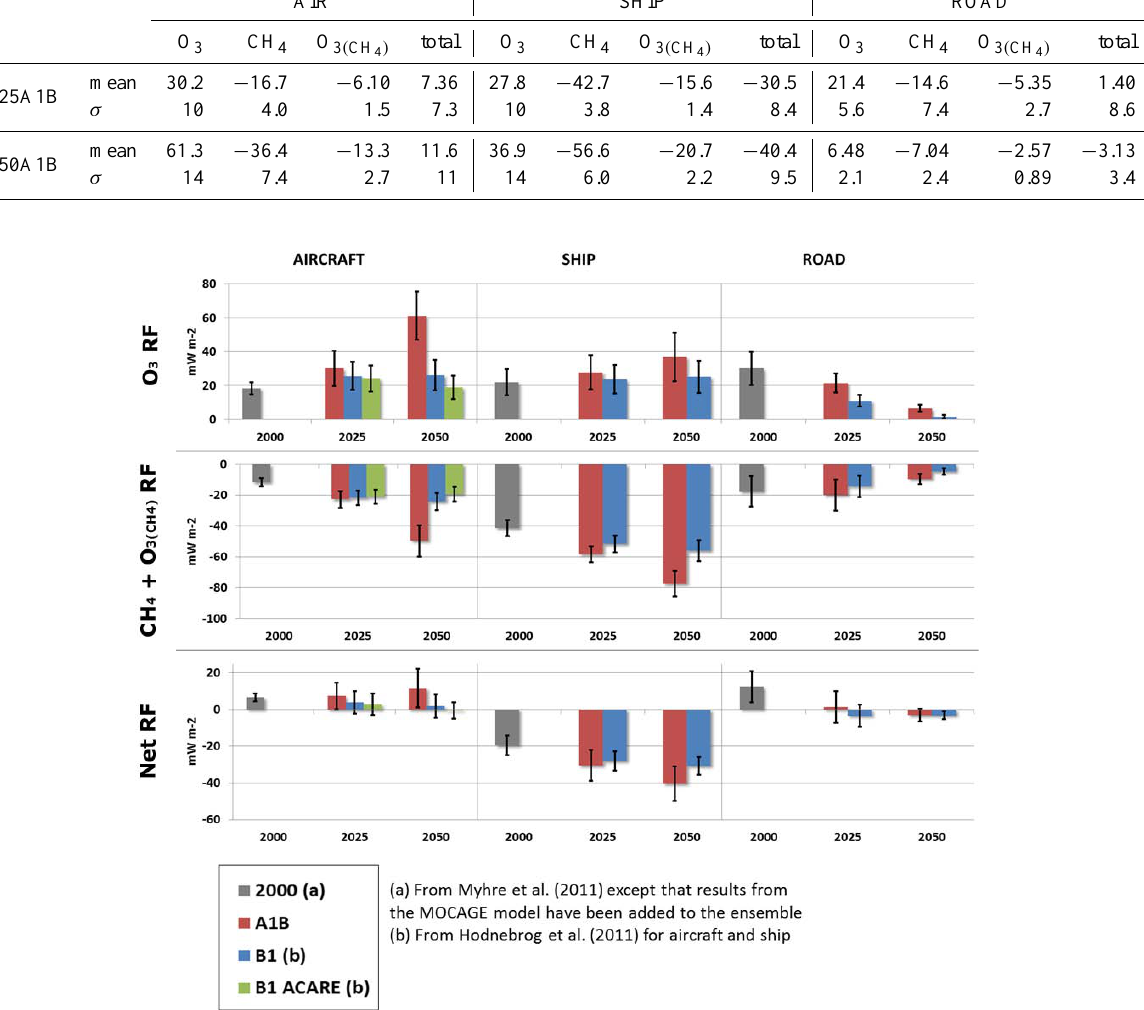
Fig. 5. Global and annual mean RF (mWm − 2 ) due to changes in short-term O 3 (top row), CH 4 including CH 4 -induced O 3 (middle row) and the net RF (bottom row) as mean (coloured bars) and standard deviation (error bars) of the six models in the ensemble. Note that the time-history of emissions and the stratospheric water vapour effect have been taken into